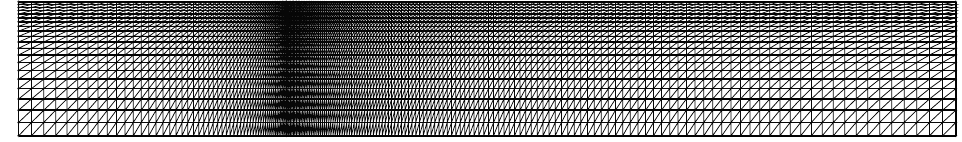
Figure 5. Two-dimensional planar swell mesh one uniform refinement step coarser compared to the mesh used throughout the remainder of this paper.